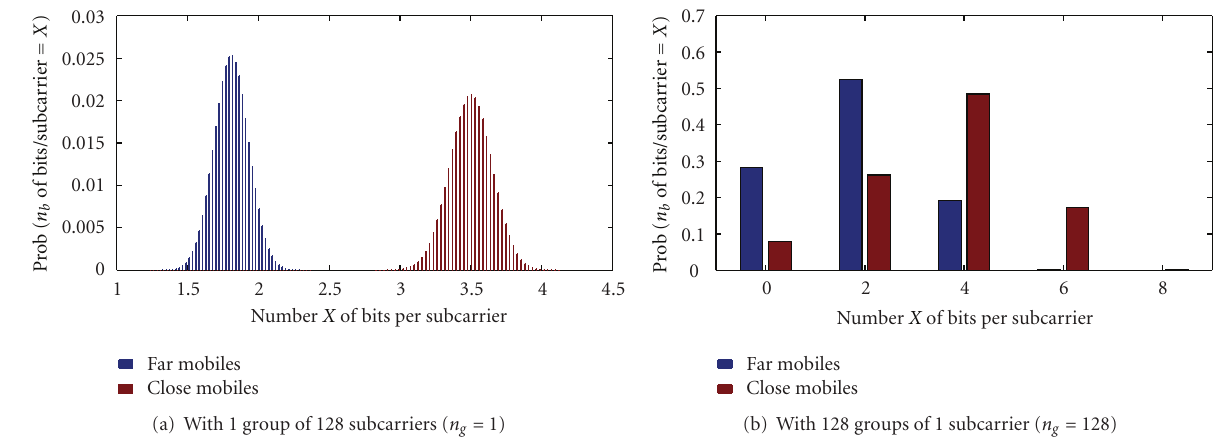
Figure 4: Number of bits per subcarrier considering two distinct bandwidth granularities.